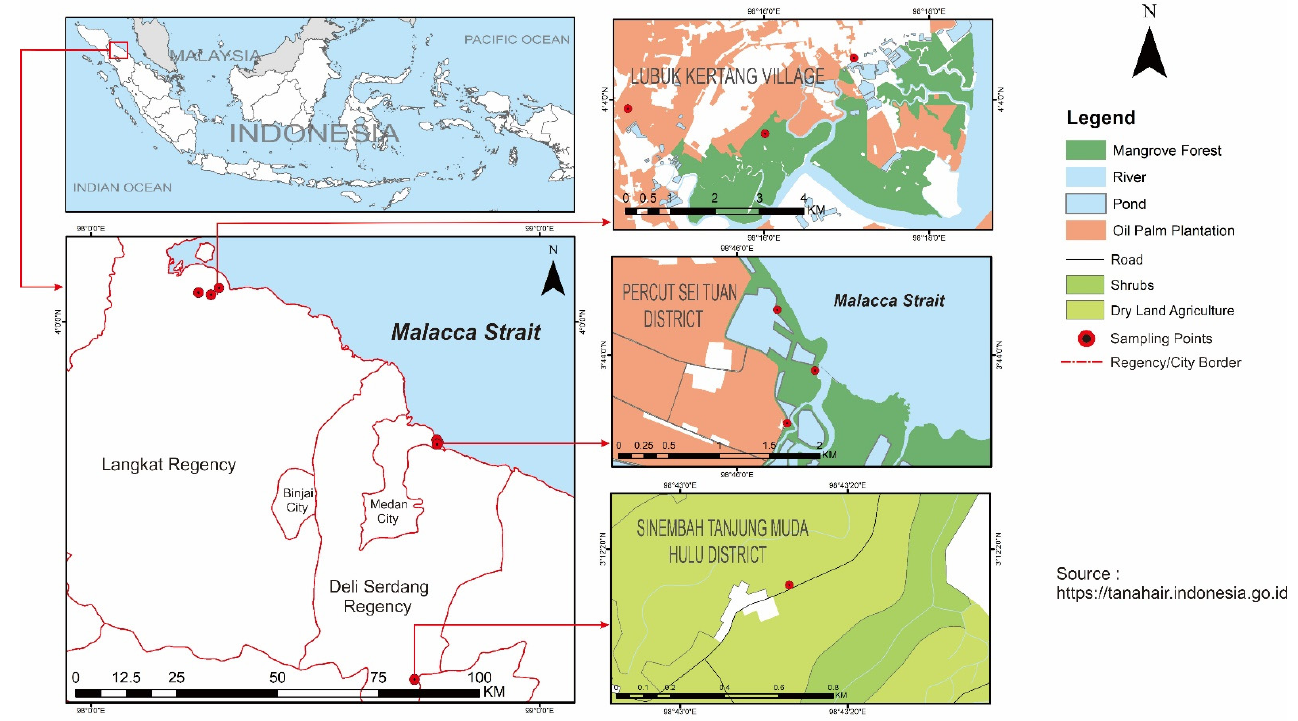
Figure 1. Sampling Location at Lubuk Kertang village, Percut Sei Tuan, and Sinembah Tanjung Muda, North Sumatra, Indonesia.